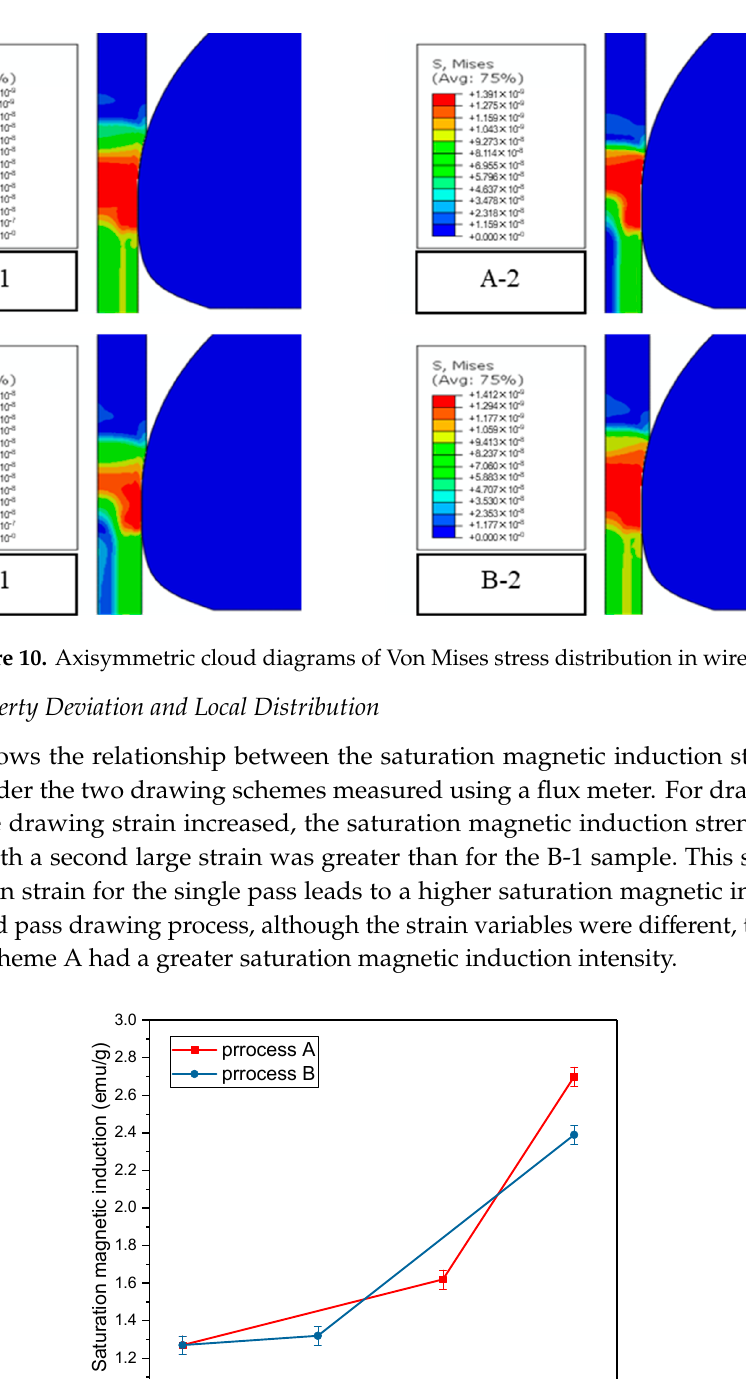
Figure 9. Axisymmetric cloud diagrams of equivalent plastic strain distribution in wires.